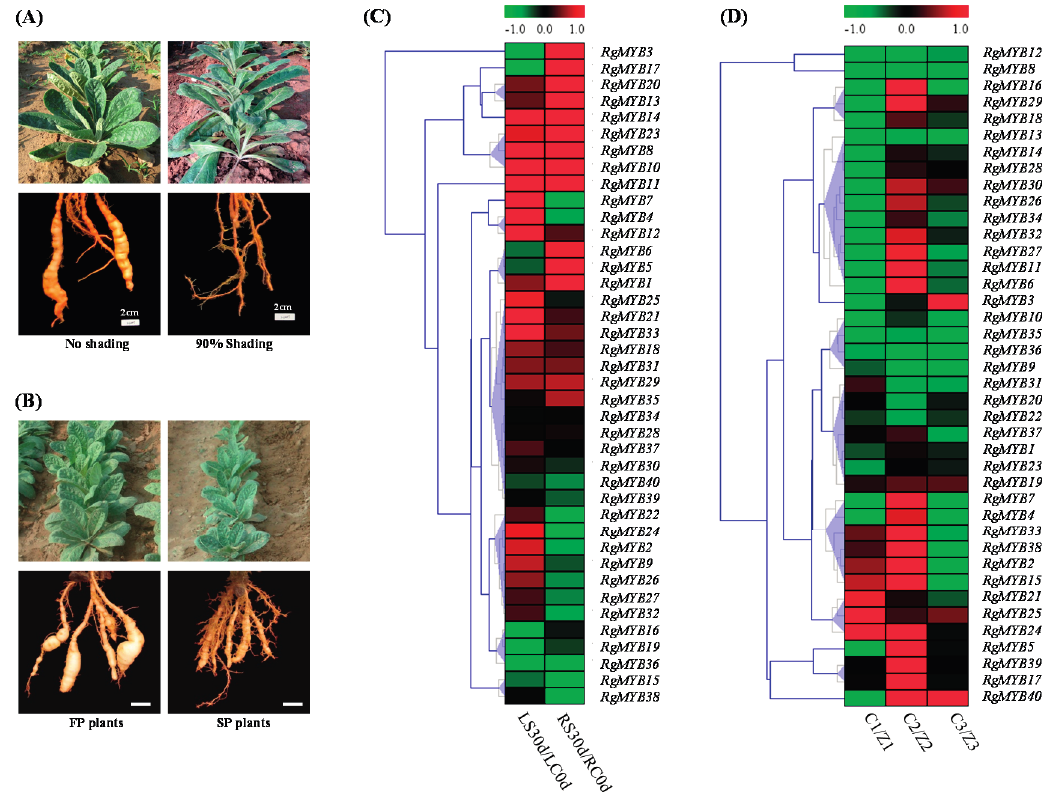
Figure 5. Growth of R. glutinosa seeding and expression profiles of R. glutinosa MYB genes under abiotic stresses. ( A ) Effect of shading stress in R. glutinosa seedlings. Thirty-day-old seedlings were shaded and grown for an additional 35 days; ( B ) Phenotypes of 90-day-old R. glutinosa plants under continuous cropping conditions; White bars: 2 cm; ( C ) Heat map showing the signal differences of 40 MYB genes in leaf and tuberous root under 90% shading compared to control; ( D ) Heat map showing the signal intensities of 40 MYB transcripts in tuberous roots at Z1, Z2 and Z3 stage under continuous cropping. The color bar presented expression level of genes: green shows the low expression, and red color shows high expression level. Z1, Seedling stage; Z2, Elongation stage of tuberous root; and Z3, Pre-expanding stage of tuberous root. The heat maps were generated by MultiExperiment Viewer